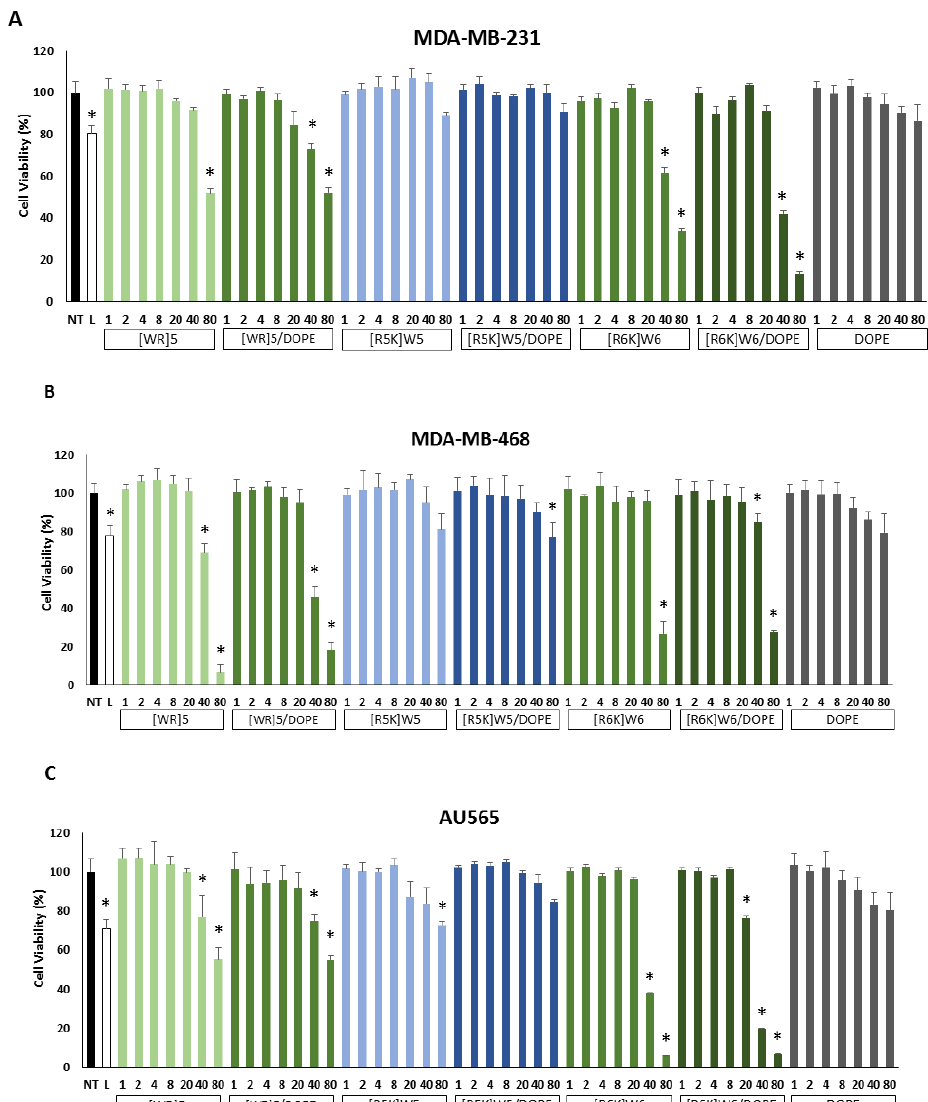
Figure 6. The toxicity of [WR] 5 (with and without addition of DOPE) in ( A ) MDA-MB-231 Cells, ( B ) MDA-MB-468, and ( C ) AU565 cells with different N/P ratios (from 1 to 80) (CCK assay; n = 3). The viability is normalized to cells treated with normal saline (no treatment, or ‘ NT ’ group). DOPE study group received DOPE alone, with the same final concentration incorporated in the delivery system at corresponding N/P ratios. The error bars indicate standard deviation. Asterisks indicate significant difference ( p < 0.05) with the ‘ NT ’ group.